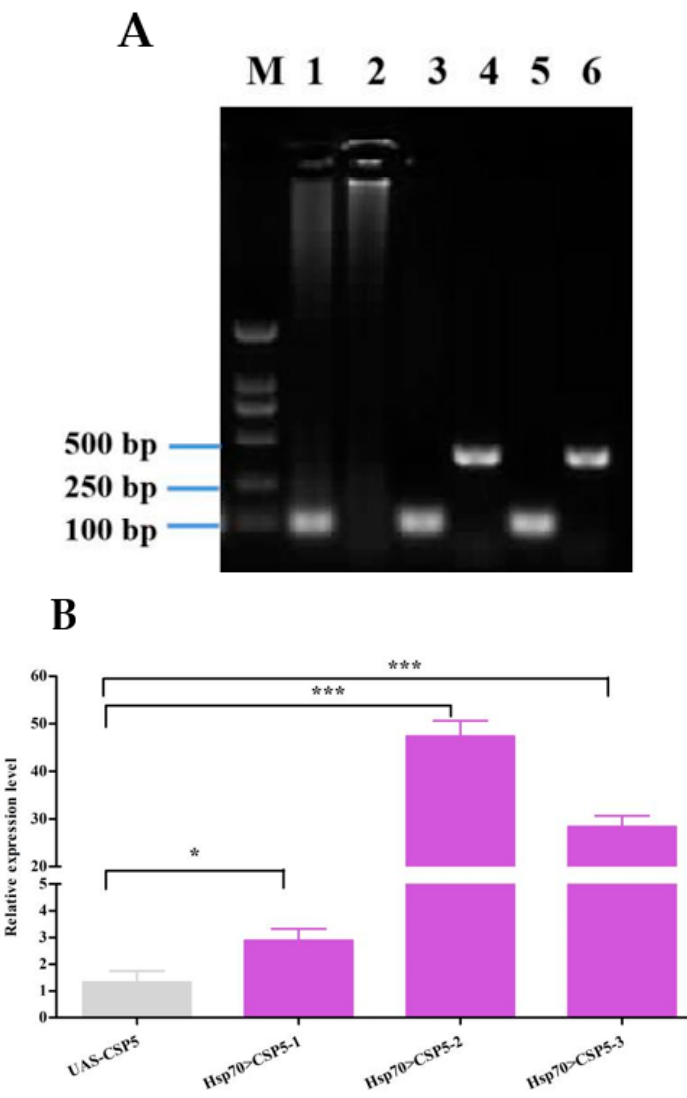
Figure 3. Integration of AgosCSP5 into the genome of the transgenic D. melanogaster. A . PCR products amplified from